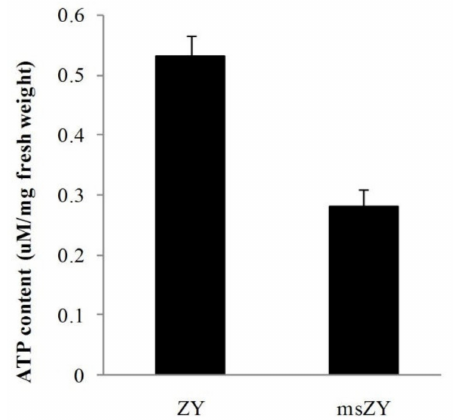
Figure 4. ATP content of flower buds of msZY and